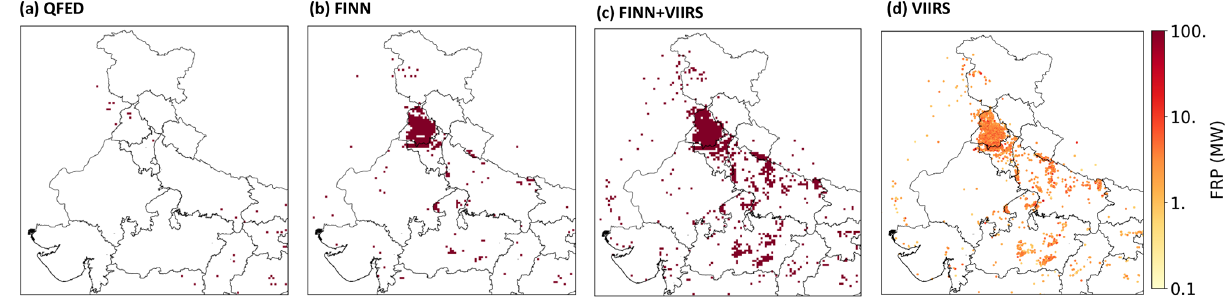
Figure 9. Spatial fire coverage in different datasets for 5 November: (a) QFED fire grid cells; (b) FINN fire grid cells; (c) FINN fire grid cells, missing points filled with VIIRS; and (d) VIIRS active fire points and corresponding FRP